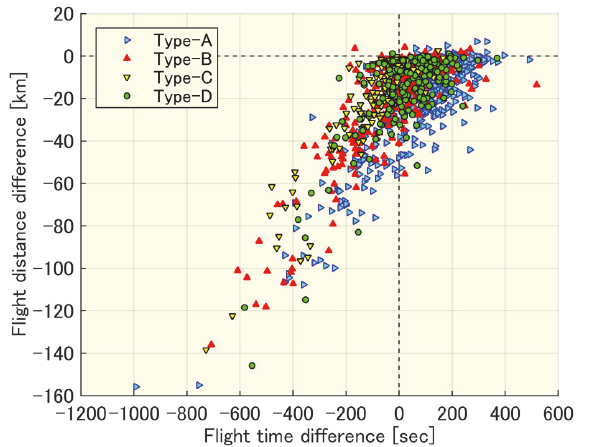
Figure 7: Flight distance difference of the optimal trajectories relative to the original flights (1087 cases).